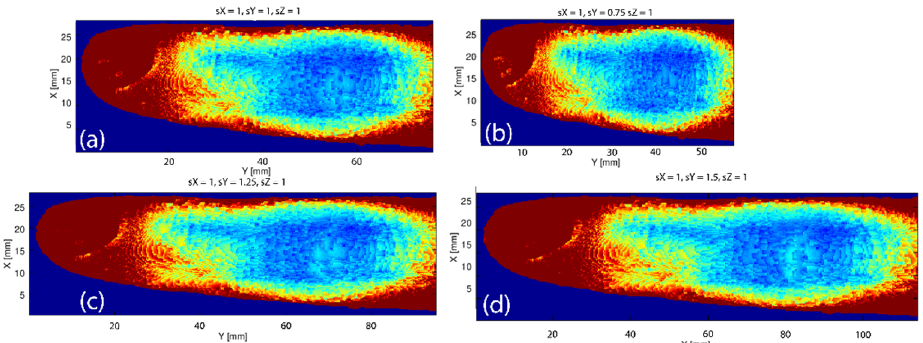
Figure 7. Results of Monte Carlo simulations of optical transmission through the model of human index finger at 860 nm with geometry scaled along the long axis of the finger (in the y-direction): ( a ) base case; ( b ) scaling of the model by 75% along the y axis; ( c ) scaling of the model by 125% along the y axis; ( d ) scaling of the model by 150% along the y axis.